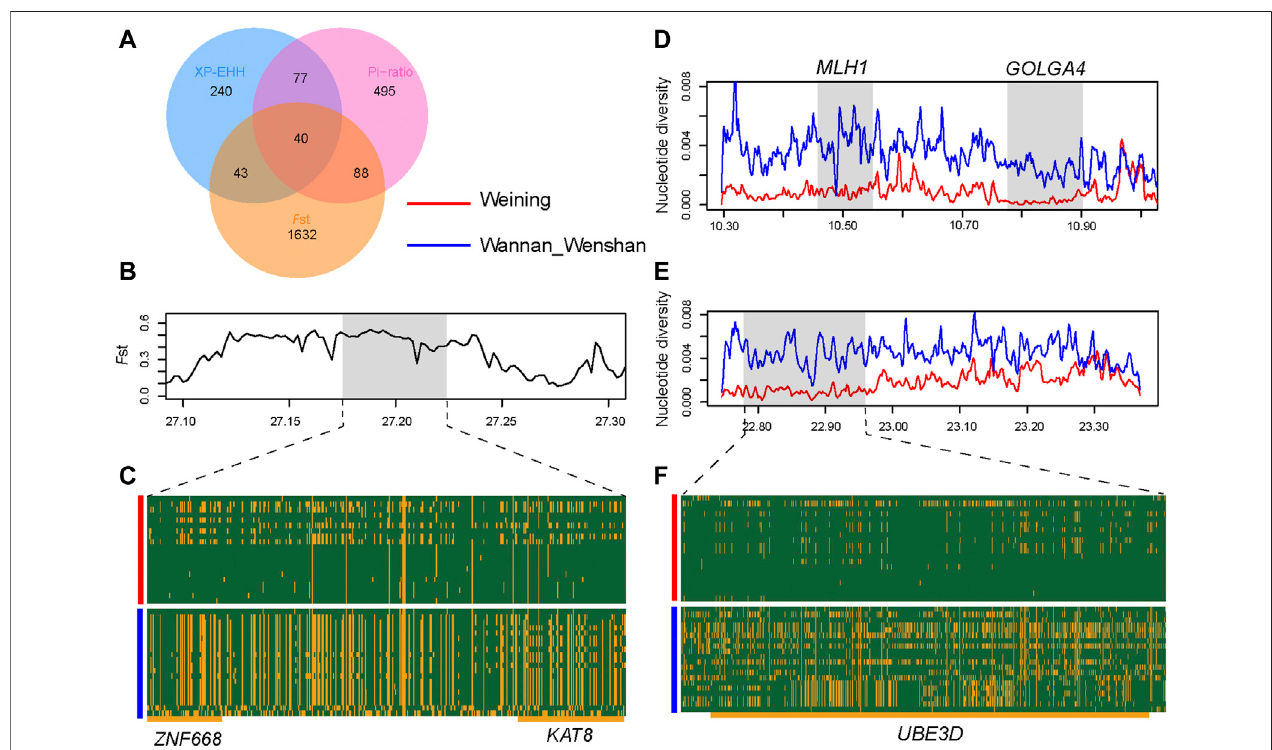
FIGURE 4 | Analysis of the signatures of positive selection in the genome of Weining. (A) Venn diagram showing the gene overlap among θπ -ratio, F ST, and XP- EHH. (B) F ST at the ZNF668 and KAT8 gene region. (C) SNPs with minor allele frequencies > 0.05 are used to construct haplotype patterns (Chr 25: 27.17 – 27.22 Mb). (D) Nucleotide diversity plots of the MLH1 and GOLGA4 genomic region. (E) Nucleotide diversity plots of the UBE3D genomic region. (F) SNPs with minor allele frequencies > 0.05areusedtoconstructhaplotypepatterns(Chr9:22.77 – 22.96 Mb).ThemajoralleleateachSNPpositioninWeiningiscoloredinyellow,andthe minor one in